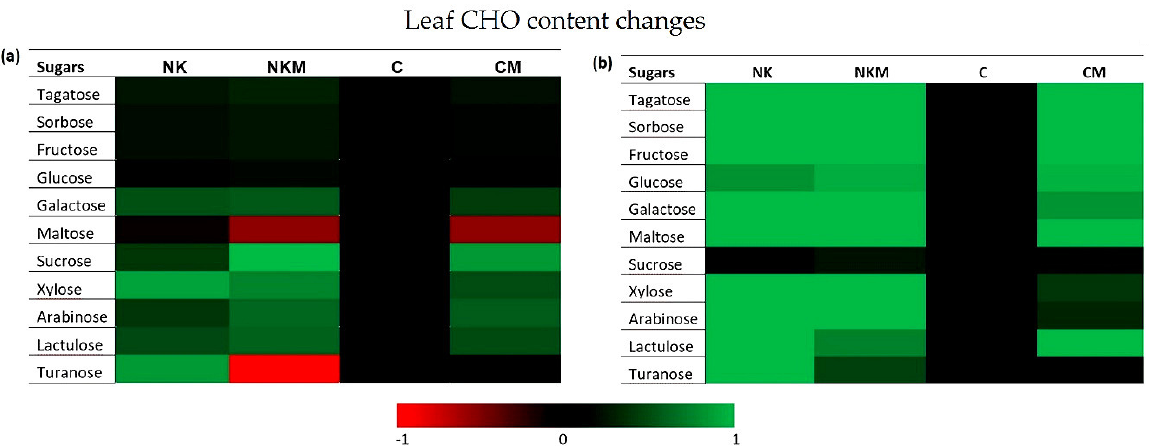
Figure 3. Heatmap of leaf CHO content changes in all treatments (NK: KNO 3 fertilizer; NKM: KNO 3 in combination with PGPR; CM: NH 4 NO 3 fertilizer in combination with PGPR) in comparison with the control (C: NH 4 NO 3 fertilizer) in the first ( a ) and second ( b ) sampling periods. The green color indicates increased levels of metabolites, while the red color indicates decreased levels of metabolites. Amounts have been expressed as relative abundance based on the relative response compared to the internal standard (adonitol).